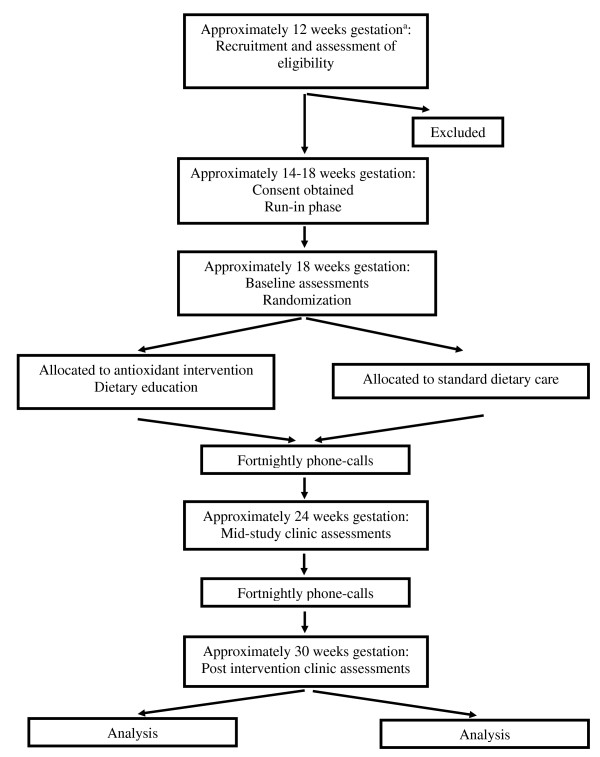
Flow diagram of the progress through the phases of the randomized controlled trial. aWomen attending their first antenatal visit at 10 to 14 weeks gestation will be recruited. The run-in phase and intervention will start 2 weeks and 4 weeks following recruitment and consent.